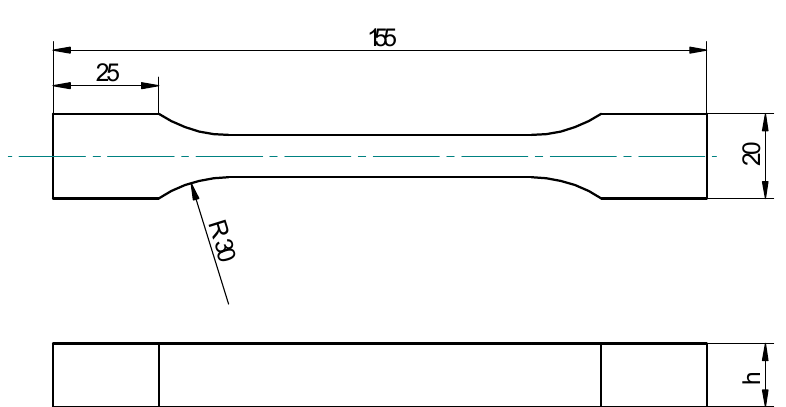
Figure 3. Geometry and dimensions of the prepared epoxide compositions sample.